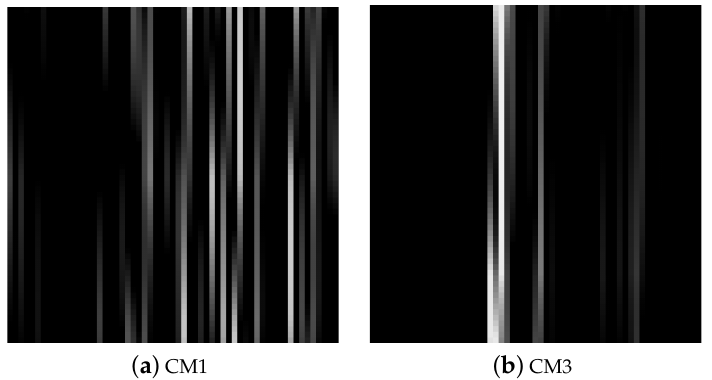
Figure 7. Average input images with emphasized contrast through a monochrome image. ( a ) CM1. ( b ) CM3.